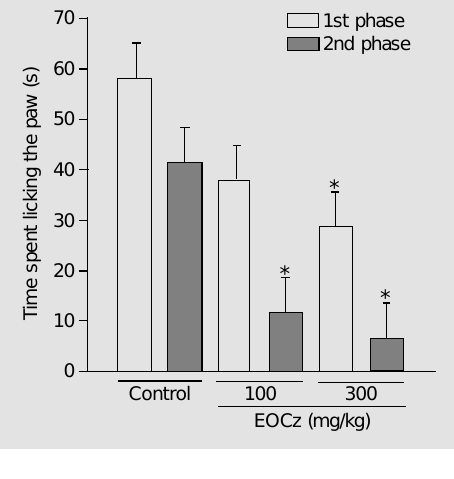
Figure 2. Effects of the essential oil of Croton zehntneri (EOCz) on thermal nociception in mice submitted to the hot-plate test. Abscissa , time (min) after oral administration of EOCz. Ordi- nate , latency (s) for the response to thermal stimulation (50 ± 0.5 o C). Data are reported as means ± SEM (N = 10) for each EOCz dose. *P<0.05 compared to control at a given time (ANOVA, Dunn’s